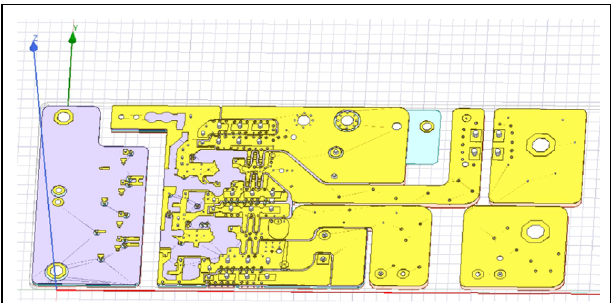
FIGURE 4 | Switching loss of MOSFETs under hard switching.